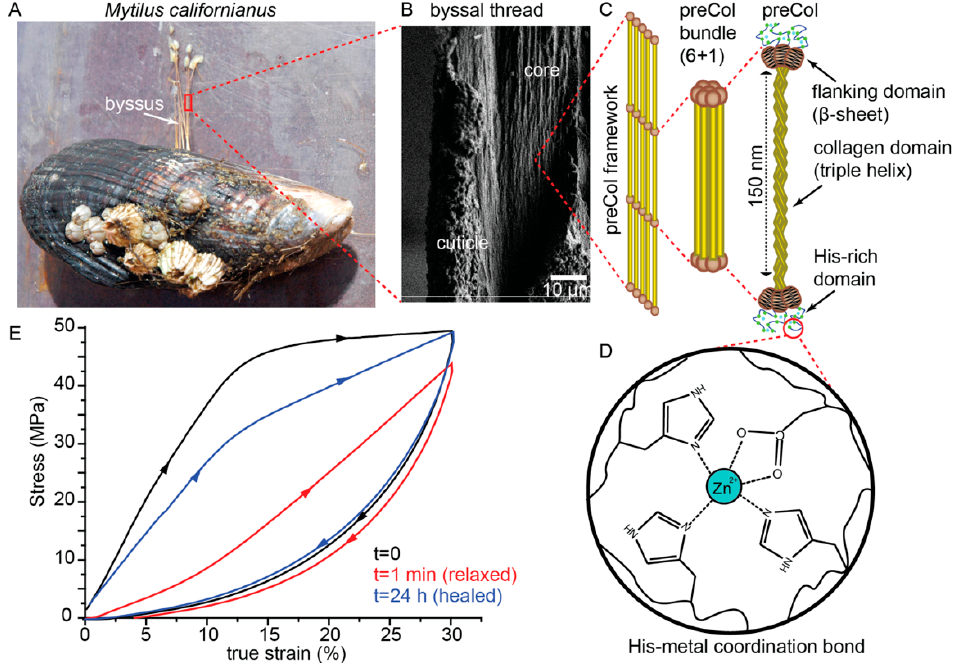
Figure 2. Mussel byssus healing and hierarchy. ( A ) Mussels from the genus Mytilus utilize proteinaceous attachment fibers collectively called a byssus to attach to hard surfaces on rocky seashores. ( B ) The distal thread core (surrounded by a thin protective coating) provides the mechanical resistance to crashing waves. ( C ) The thread core consists of multidomain collagenous proteins known as prepepsinized collagens (preCols) which are hierarchically organized into a semi-crystalline framework. ( D ) The histidine-rich domains (HRDs) at the ends of preCols are known to coordinate Zn 2+ ions, which function to influence mechanical performance. ( E ) During cyclic tensile testing, threads exhibit a large mechanical hysteresis, but undergo damage when loaded past the yield point. Autonomous and intrinsic self-healing occurs over time to recover toward initial properties. Reprinted from [4], Copyright 2016, with permission from